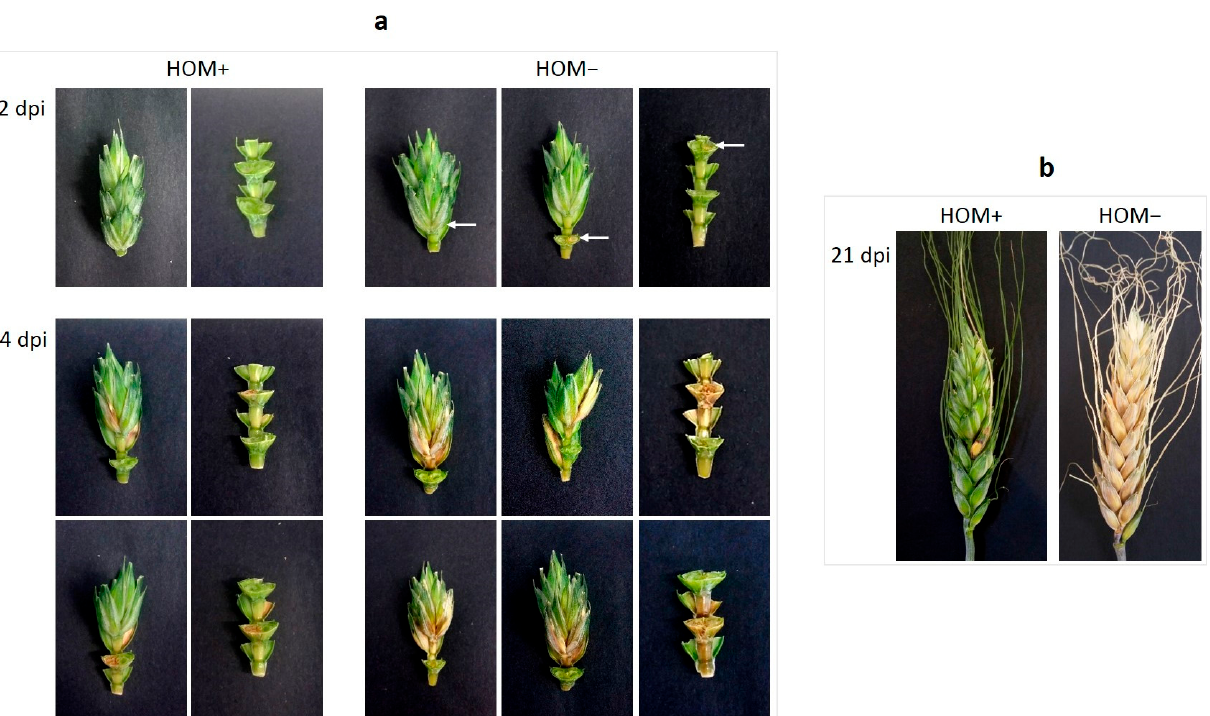
Figure 2. Examples of phenotypes of Fg -inoculated spike sections at 2 and 4 days post inoculation (dpi) ( a ) and of the whole spike at 21 dpi ( b ) for the resistant HOM+ and susceptible HOM − genotypes. White arrows indicate early browning of the inoculated floret of the susceptible genotype.